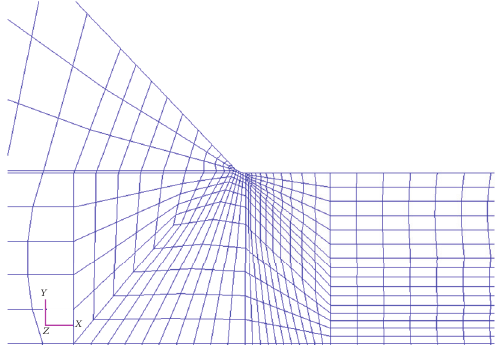
Figure 19: Weld toe configuration.